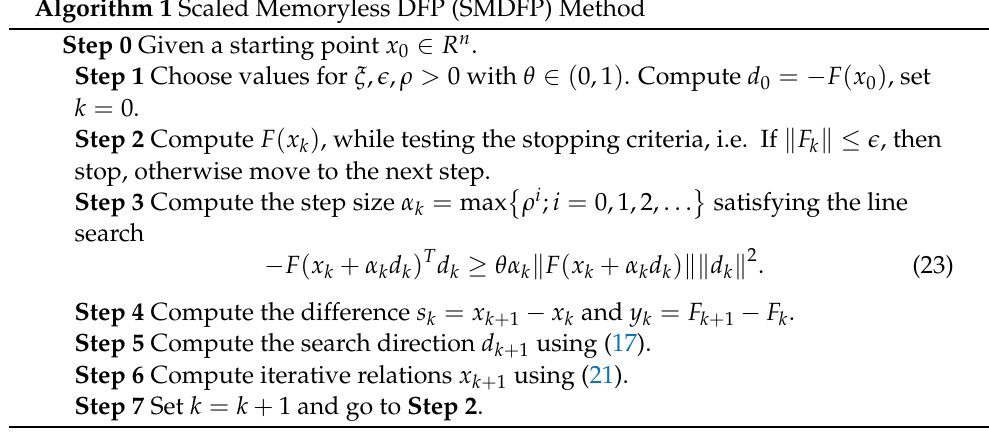
Algorithm 1 Scaled Memoryless DFP (SMDFP)